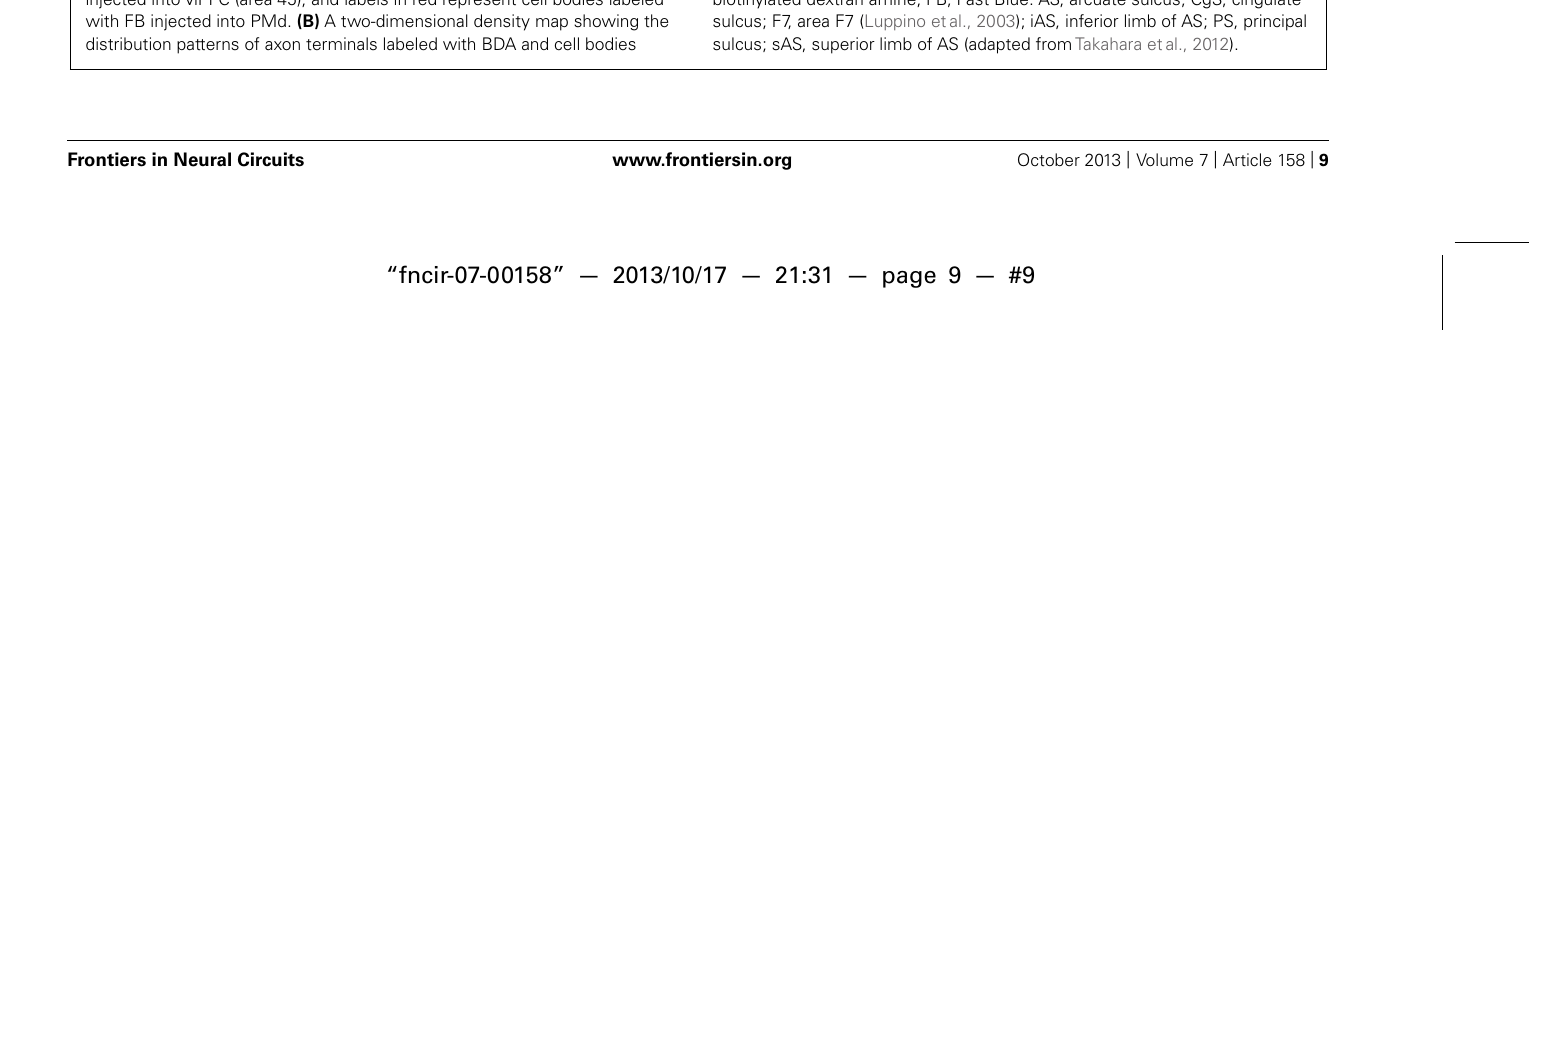
labeled with FB.The bins (900 × 1,000 μ m) where the BDA-labeled axon terminals were observed appear in blue.The box encloses the area where BDA terminals were investigated.The gray zone denotes the extent of the FB or BDA injection sites.Three different sizes of filled circles represent the numbers of neurons labeled with FB. Arrowheads (a–e) point to the approximate rostrocaudal levels of coronal sections (a–e) shown in (A) . BDA, biotinylated dextran amine; FB, Fast Blue. AS, arcuate sulcus; CgS, cingulate sulcus; F7, area F7 (Luppino etal., 2003); iAS, inferior limb of AS; PS, principal sulcus; sAS, superior limb of AS (adapted fromTakahara etal.,